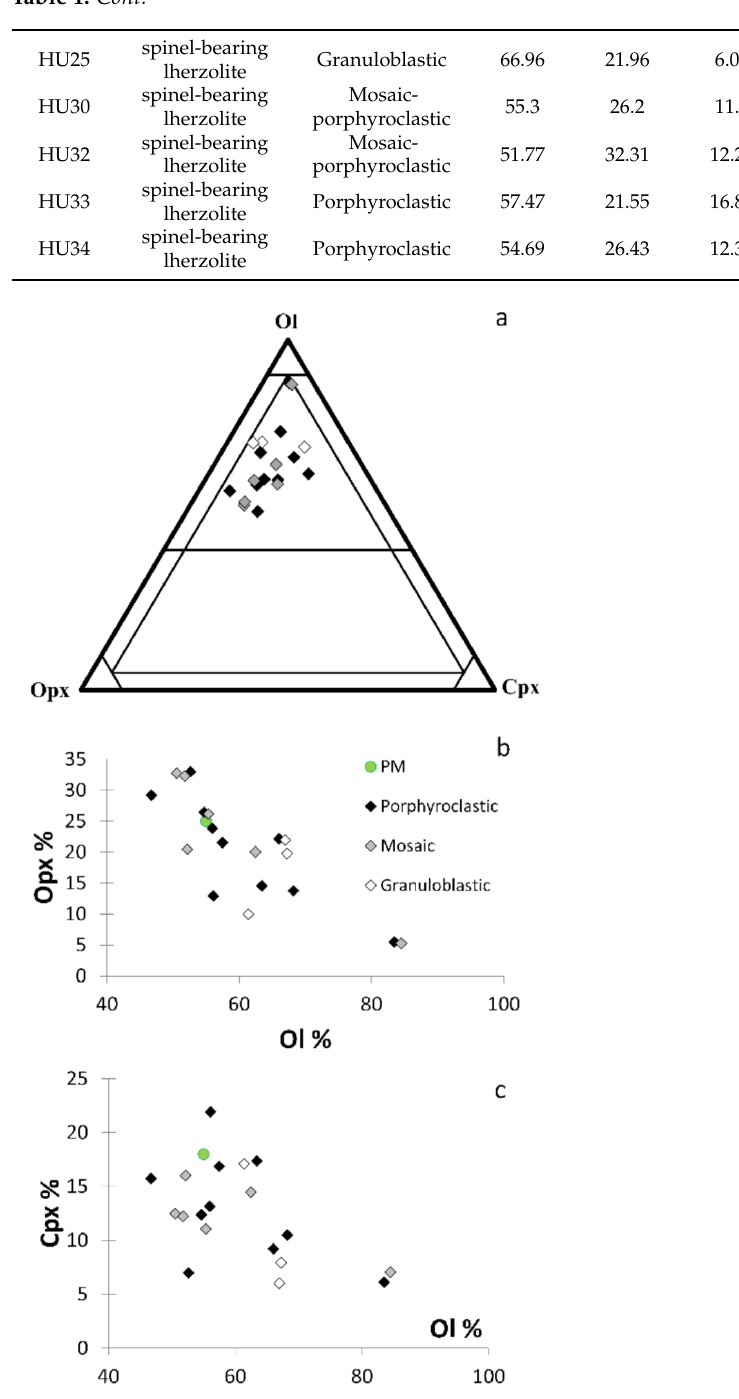
Figure 3. ( a ) Modal classification of Huanul mantle xenoliths showing that our samples have lherzolitic composition. Modal compositions were estimated by point counting (minimum 1200 points for sample). ( b ) Orthopyroxene and ( c ) clinopyroxene versus olivine content in the Huanul lherzolitic xenoliths. Textures after [46] vary from porphyroclastic (10 samples) to mosaic-porphyroclastic (6 samples) to granuloblastic (3 samples) (Figure